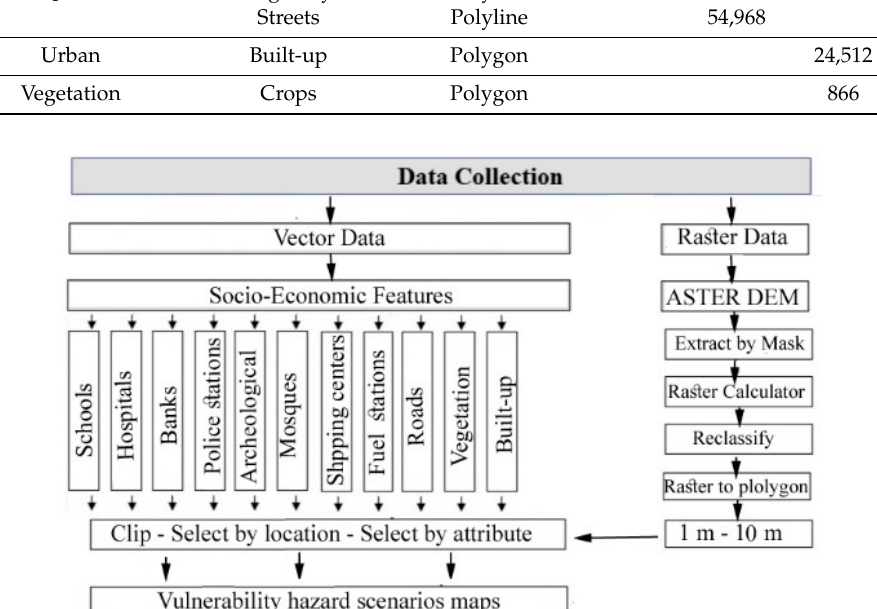
Figure 2. A flow chart diagram highlighting the outline of the data processing in this study.